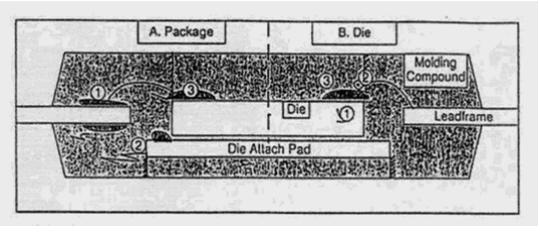
Figure 5. Micromirror (after [6]). Figure 6. Evolution of microtechnology.